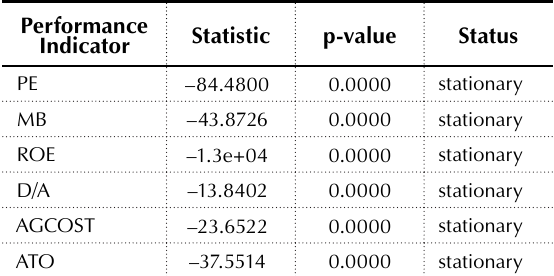
Table 6. Results of unit root test of stationarity Performance Indicator